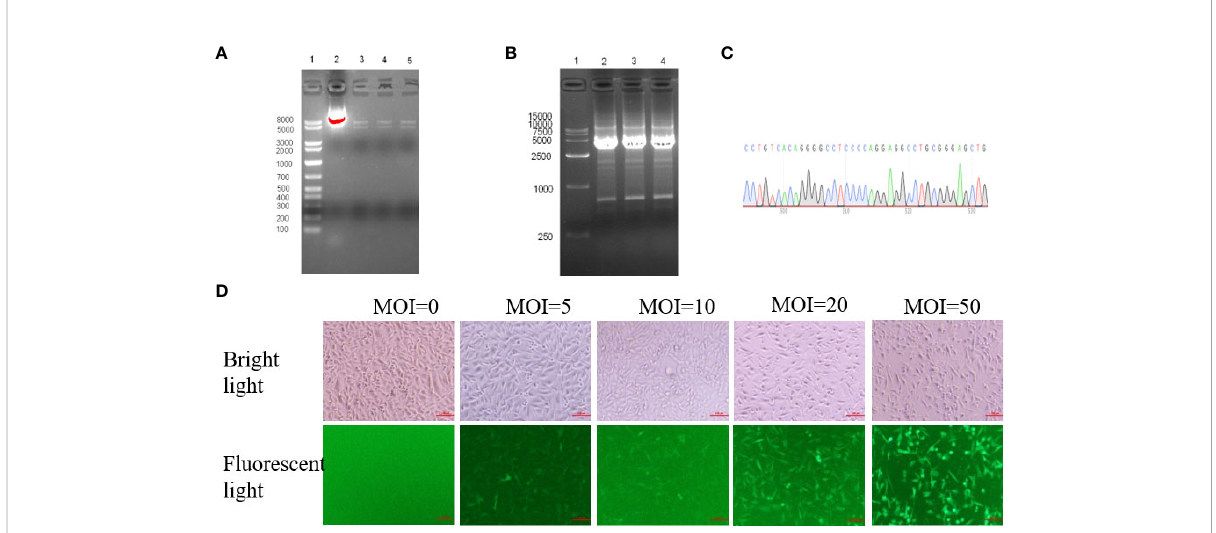
FIGURE 2 HER2 overexpression was generated in MDA-MB-231 cells using a lentivirus vector system. (A) After double restriction endonuclease Sph1 and Nhe1 digestion, electrophoresis showed two speci fi c target bands of about 5kbp and 7kbp, line 1: Marker; line 2: Recombinant plasmid without enzyme digestion; line 3-5: Double digestion with three replicates. (B) The positive colonies of extracted plasmid were selected for PCR identi fi cation, and agarose gel electrophoresis showed a speci fi c target band of about 3.7kbp. (C) The sequences were validated by sanger sequencing(Partial display. (D) MDA-MB-231 cells were transduced by lentivirus vector at fi ve different multiplicity of infection (MOI 0, 5, 10, 20 and 50 virus particles per cell). GFP expression in cells was analyzed by fl ow cytometry 48 hours after lentivirus vector infection